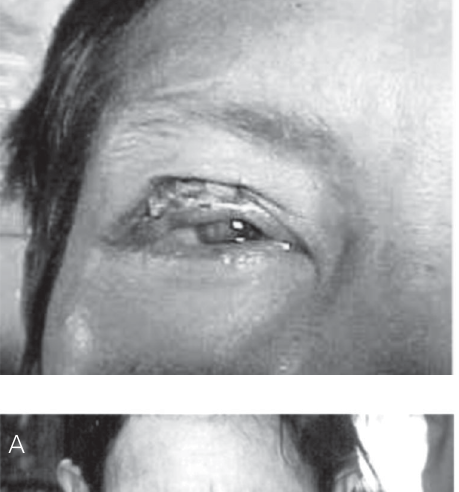
Figure 3. A , Blepharospasm in- duced by trachomatous entro- pion. B , Relief of blepharospasm after marginal rotation by a pos- terior